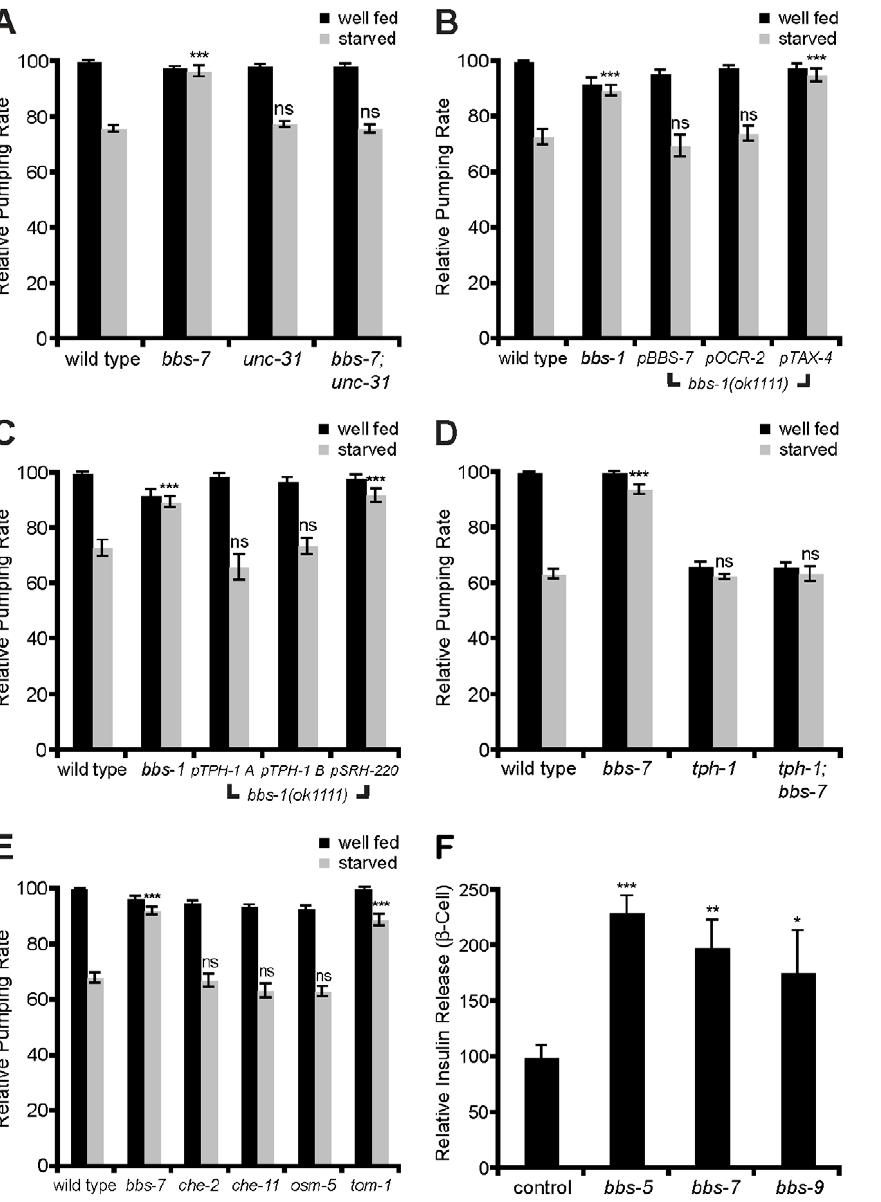
Figure 7. Reduction of dense-core vesicle secretion corrects feeding abnormalities of bbs mutants and BBS siRNA enhanced insulin secretion from b -cells. unc-31 , secretion defective mutant (A) and tph-1 serotonin synthesis mutant (D) suppress the increased pumping rate of bbs mutants when starved (*** p , .001; ns , not significant, compare to wild-type starved pumping rate). (B, C) The pumping rate of transgenic animals expressing bbs-1 cDNA under the indicated neuron-specific promoters in bbs-1 mutants was determined. Expression patterns of these promoters are listed in Table S1. Pumping rate was restored to wild-type level when bbs-1 cDNA was expressed in the sole serotonergic ciliated neuron, ADF (*** p , .001; ns , not significant, compared to wild-type starved pumping rate). (E) bbs mutants shared increased pumping rate when starved with hypersecretion tom-1 mutants in contrast to che-2 , che-11 , and osm-5 IFT mutants (*** p , .001; ns , not significant, compared to wild-type starved pumping rate). (F) siRNA against BBSome subunits in Min6 cells increases release of insulin into the surrounding media relative to control siRNA (* p , 0.05, ** p , 0.01, *** p , .001, compared to control siRNA).